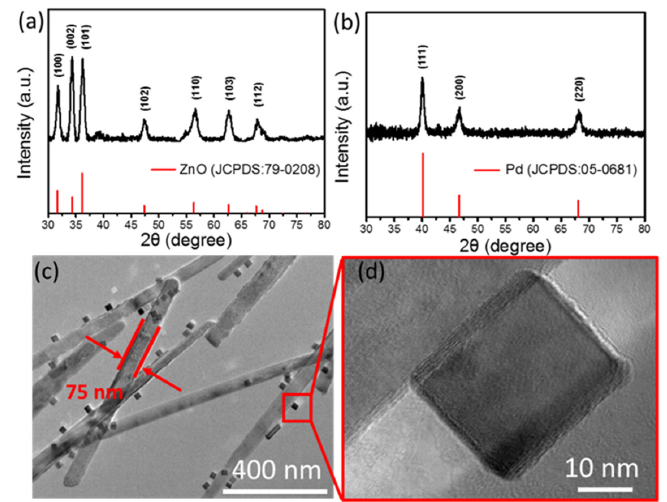
Figure 3. ( a , b ) XRD images of ZnO NWs and Pd nanoparticles. ( c ) TEM image of Pd ‐ modified ZnO NWs and ( d ) zoom ‐ in view of the Pd nanoparticle. NWs and ( d ) zoom-in view of the Pd